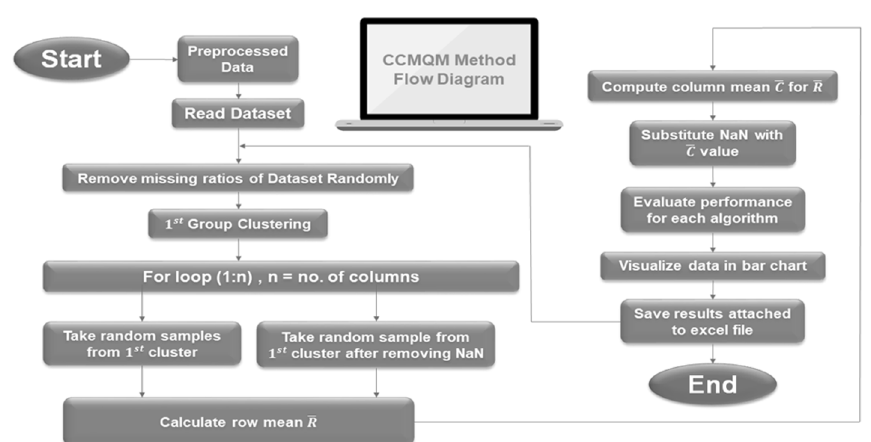
Fig. 8 Proposed system